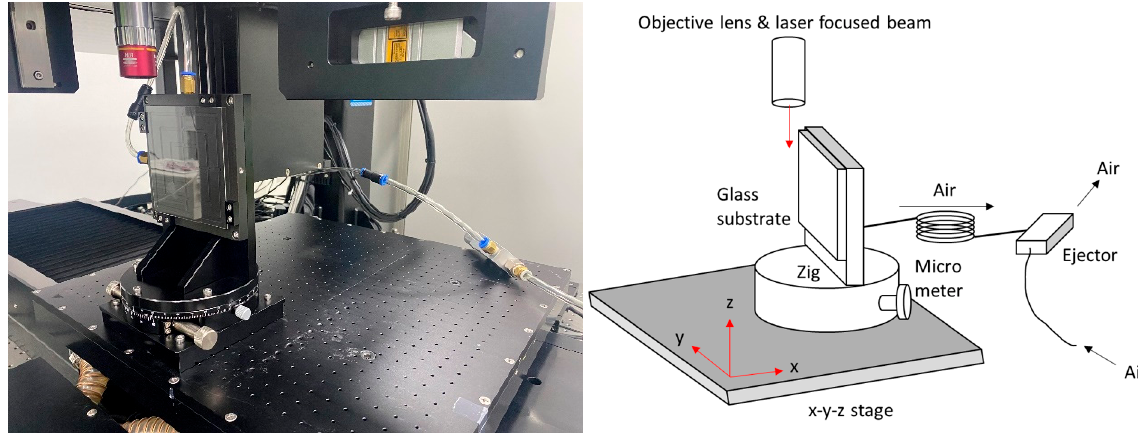
Figure 1. System configuration.